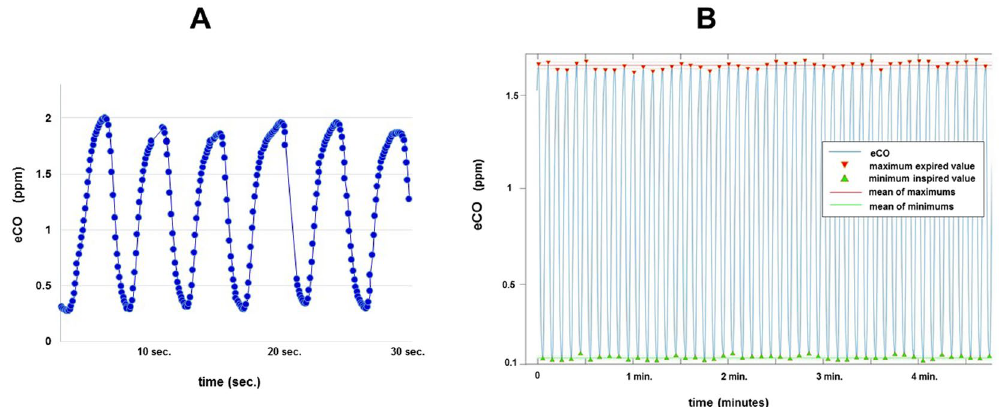
Figure 2. ( A,B ) eCO curves recorded with a ProCeas for a non-smoker healthy volunteer breathing medical air (21% FiO 2 ). ( A ) eCO is monitored with a sampling frequency of 5 Hz (one measure every 0.2 second). ( B ) Maximum (expiration) and minimum (inspiration) values are automatically detected, cycle-to cycle,